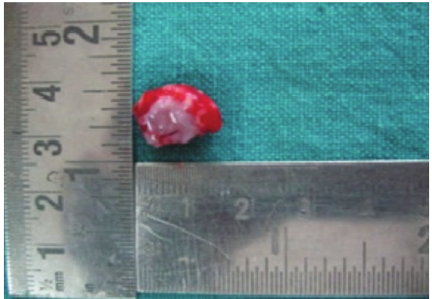
Table 1: Blood investigations.